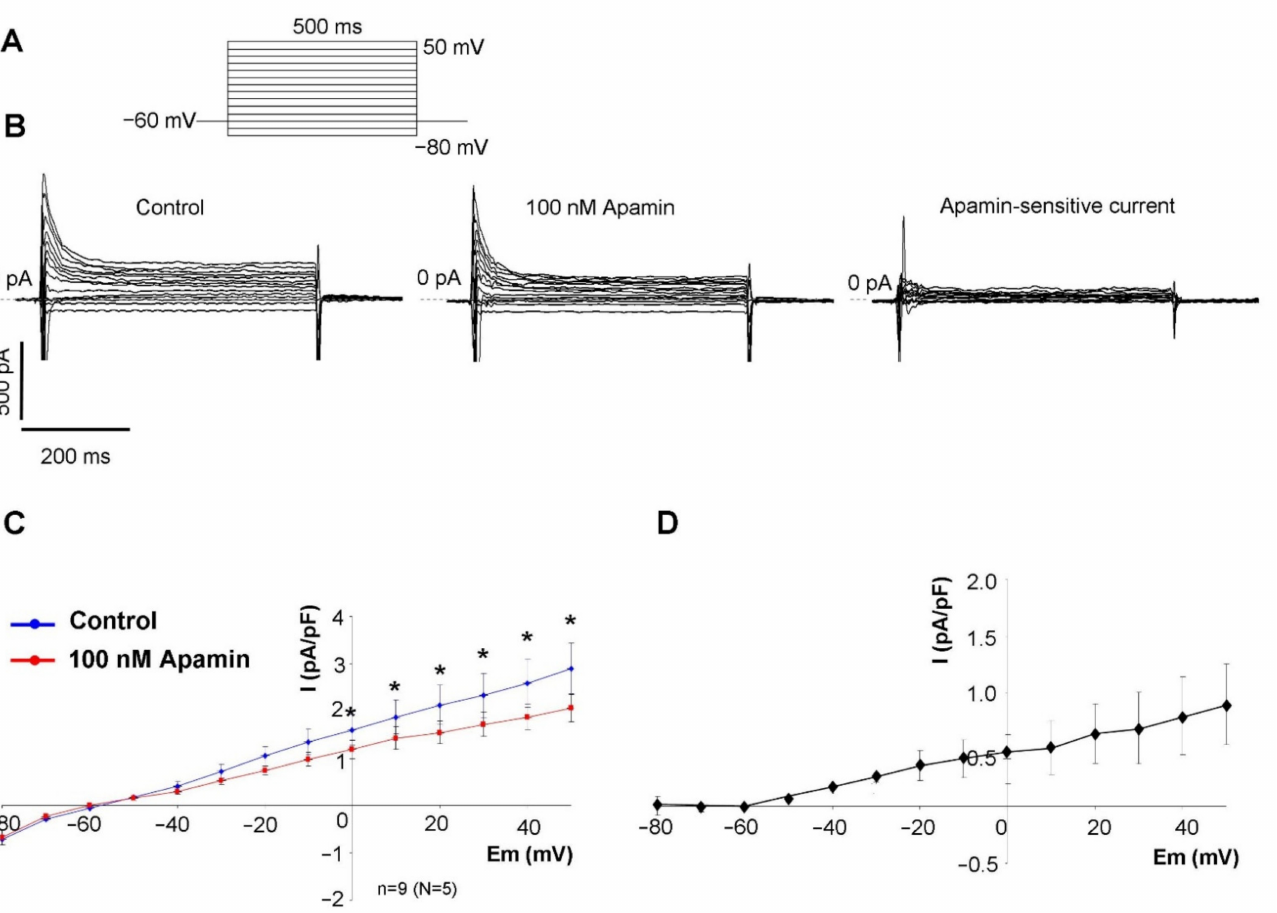
Figure 2. Characterization of the apamin-sensitive current. ( A ) illustrates the applied voltage protocol. ( B ) shows total membrane current under control condition (left curves), after 100 nM apamin application (middle curves), and the apamin sensitive current (right curves). ( C ) shows the current-voltage diagram of the control and apamin-treated currents and ( D ) illustrates the current- voltage relationship of the apamin-sensitive current. Statistical analysis was performed by paired t -test ( p <